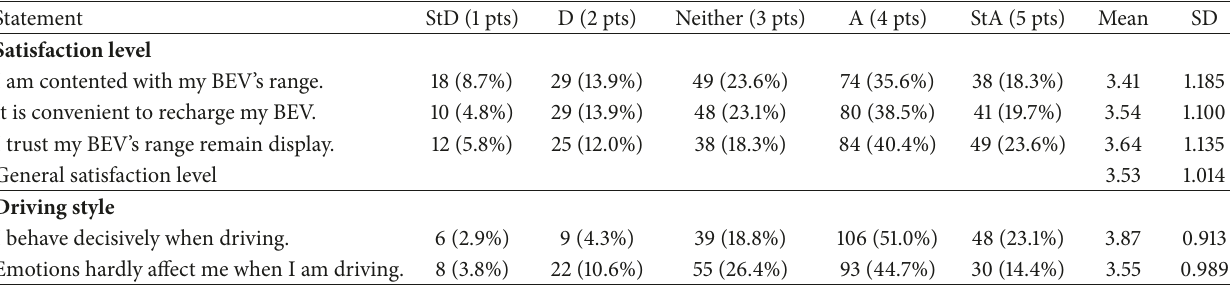
Table 2: Statistics of driver’s satisfaction level and driving style (StD: strongly disagree, D: disagree, Neither: neither agree or disagree, A: agree, StA: strongly agree; the same to the following tables).